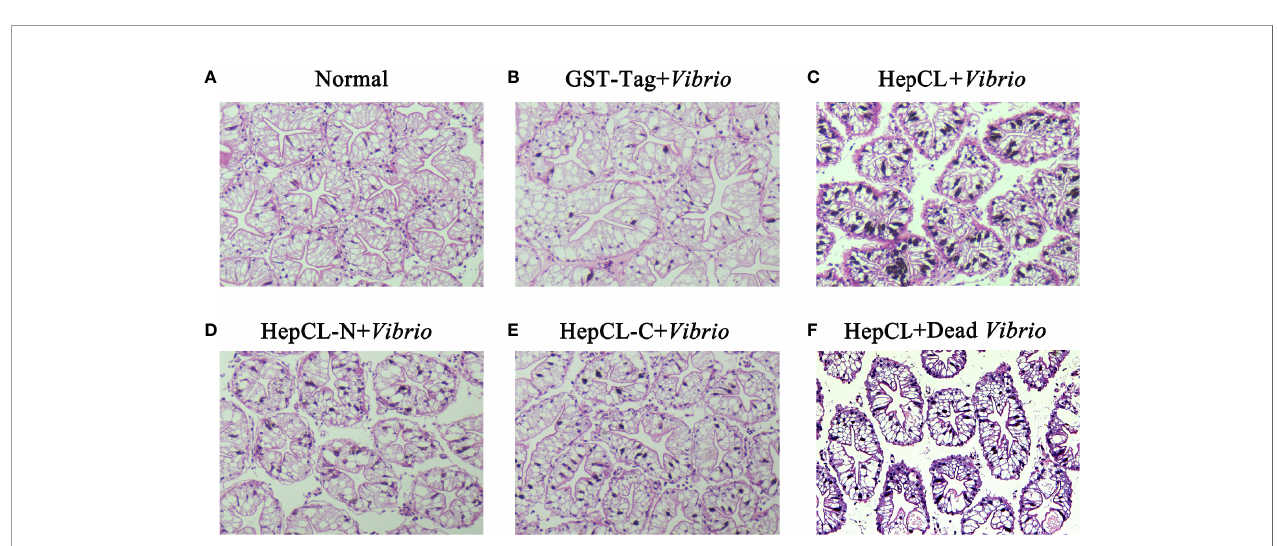
FIGURE 3 | Histological section analysis of hepatopancreas. H&E stain was used in this assay. Proteins (GST-Tag (B) , HepCL (C) , HepCL-N (D) , HepCL-C (E) were injected into cray fi sh, then cray fi sh was challenged with 10 6 Vibrio. (F) After protein HepCL injection, the cray fi sh was injected with heat-inactivated Vibrio (Dead Vibrio ). Normal cray fi sh was used as control (A)